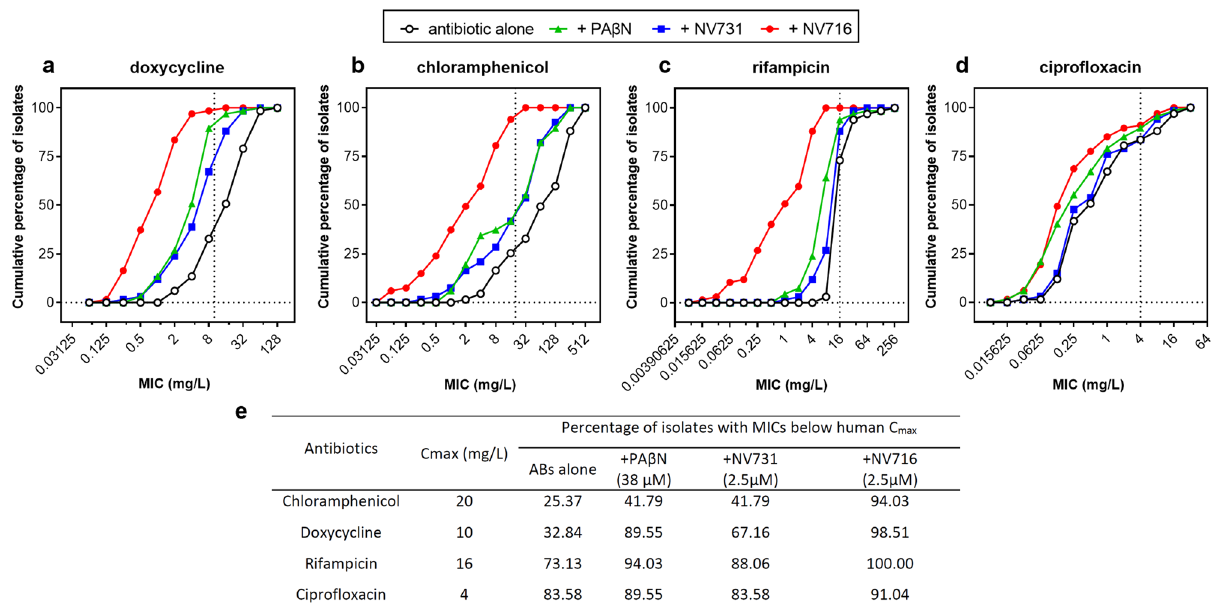
Fig. 2 Cumulative MIC distribution for antibiotics alone or combined with potentiators (38 µ M PA β N, 2.5 µ M NV731 and NV716) against clinical isolates. The vertical dotted line shows the human C max values for each antibiotic 75,76 ( a doxycycline; b chloramphenicol; c rifampicin; d cipro fl oxacin). The table e shows the proportion of isolates for which MICs are below this C max value, and thus falls in the range of therapeutically-achievable concentrations. All MICs were determined in at least 2-3 independent experiments (if values differing of 1 – 2 dilutions were obtained, the most frequent one was